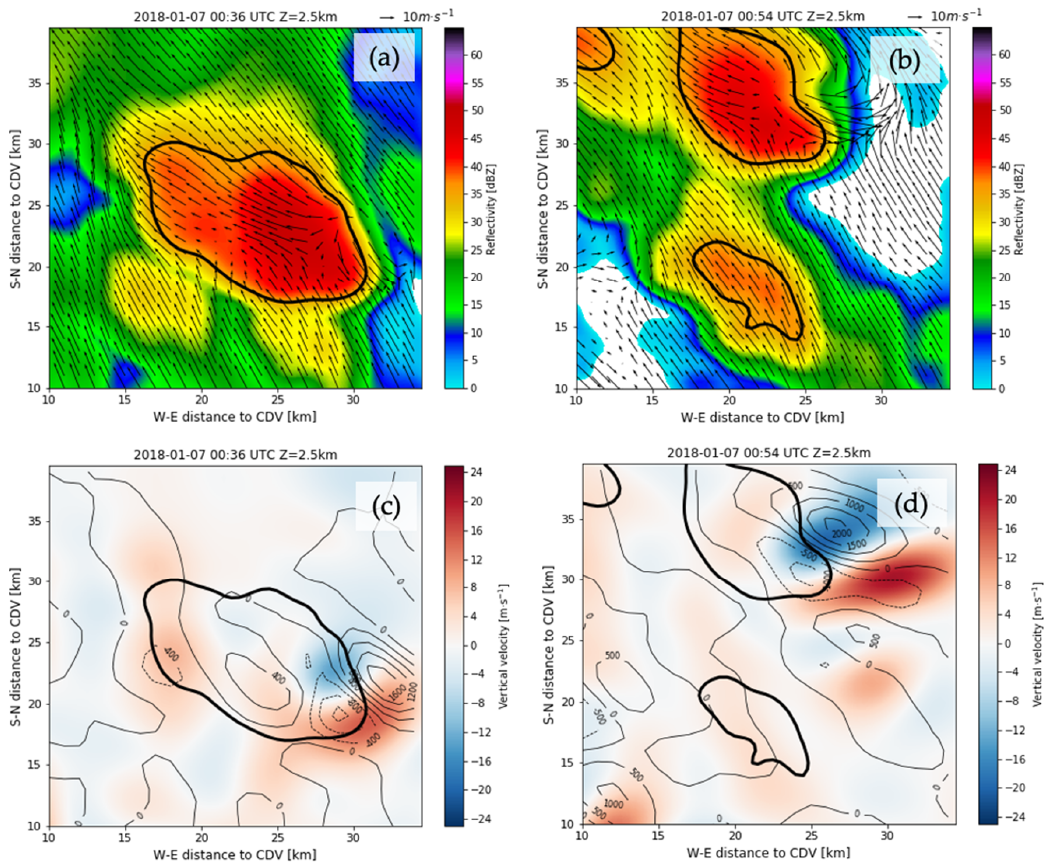
Figure 7. Retrieved SAMURAI fields for the supercell case on 7 January 2018 at 00:36 and 00:54 UTC. ( a , b ): Reflectivity (dBZ) and storm-relative horizontal wind field (m · s − 1 ) (with black arrows). ( c , d ): Vertical velocity in color scale ( w , in m · s − 1 ) and vertical vorticity ( ζ , in 10 − 5 · s − 1 ), represented with black contours (dashed and solid for negative and positive values, respectively). Contours are labeled every 200 × 10 − 5 · s − 1 (0 value not shown). The 35 dBZ contour is depicted with the thick black line.